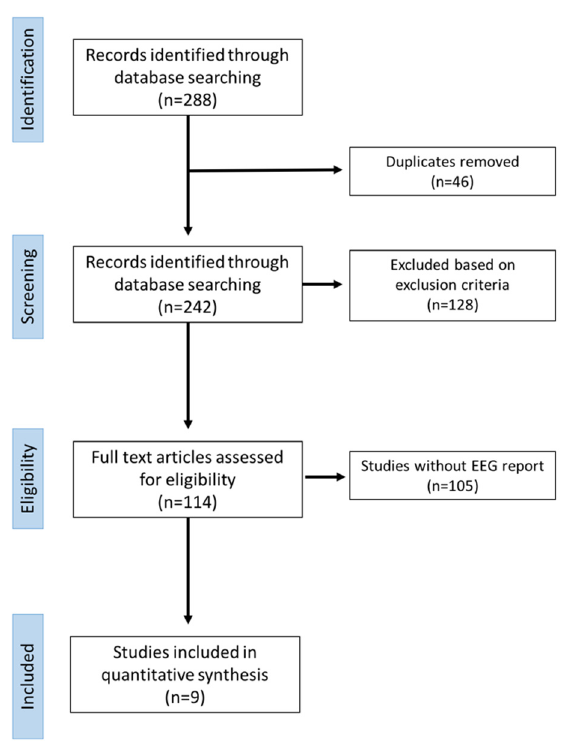
Figure 3. PRISM(cid:31) flowchart of the selection of the studies for this review. Figure 3. PRISMA flowchart of the selection of the studies for this